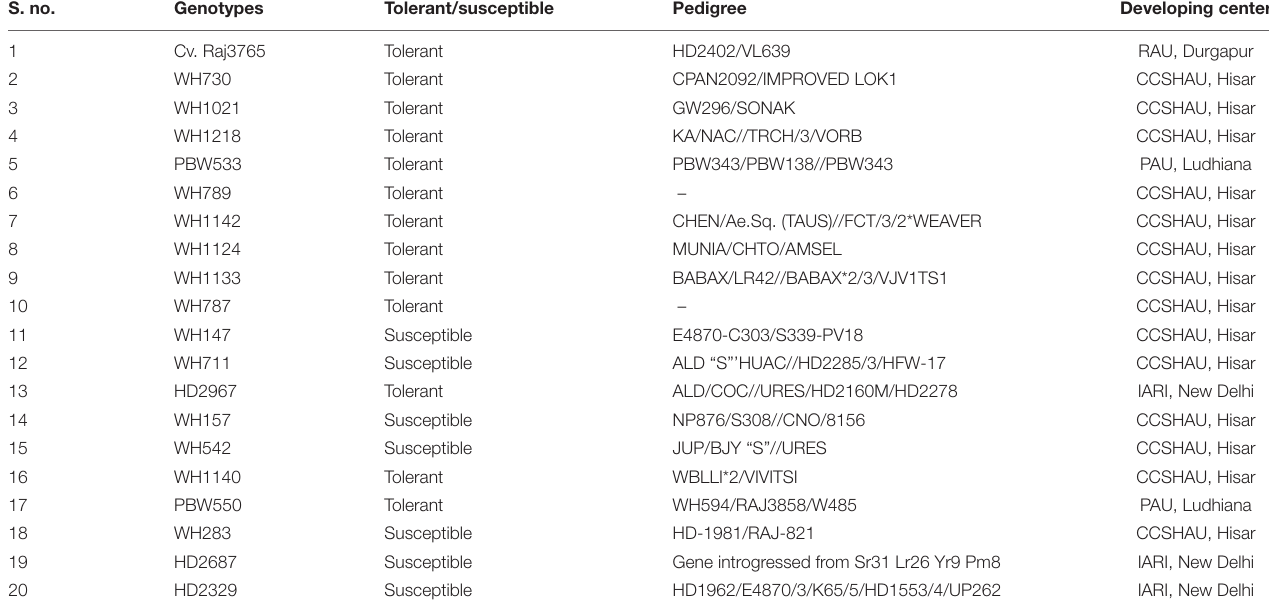
TABLE 1 | Details of 20 terminal heat-tolerant and heat-susceptible wheat genotypes used in this study. S.